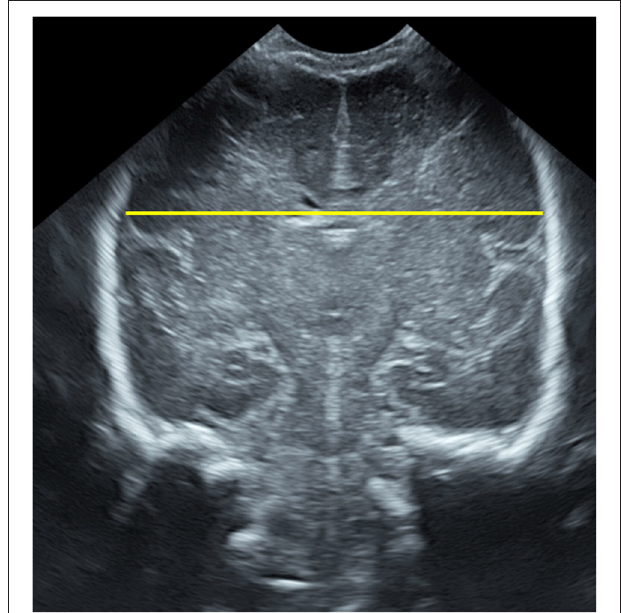
FIGURE 1 | Biparietal diameter measured on the ultrasonographic third coronal plane.